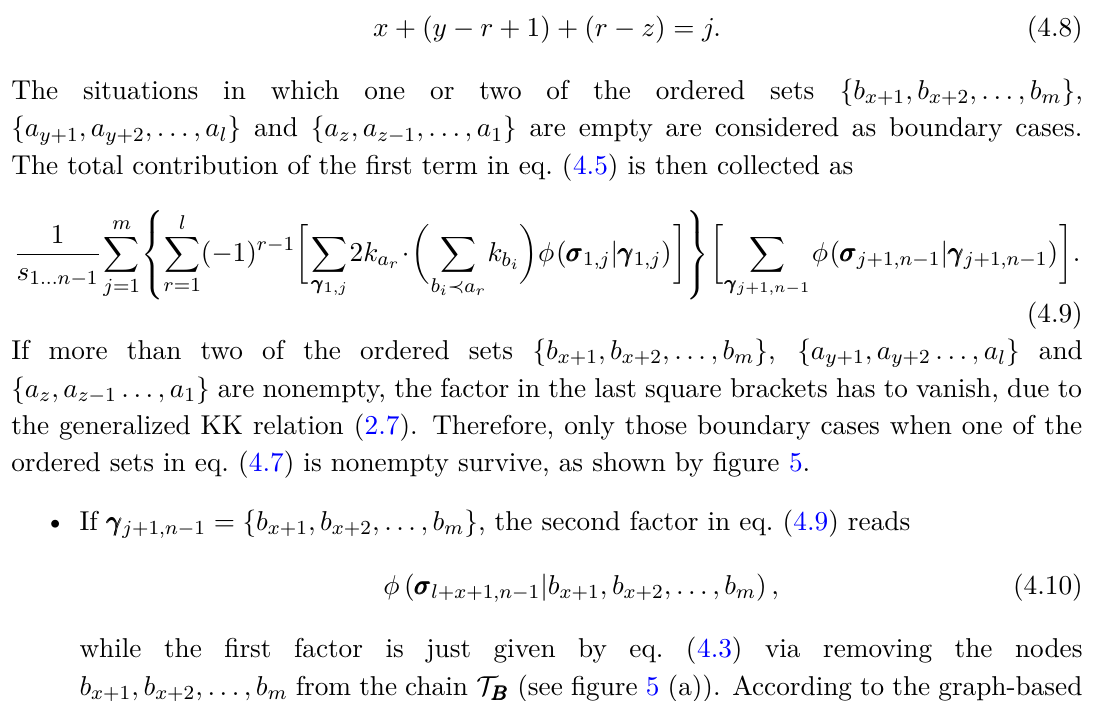
Figure 5 . Four types of graphs contributing to (4.9). In each graph, the boxed subgraph containing the element b contributes to permutations γγγ 1 to γγγ j +1 ,n − 1